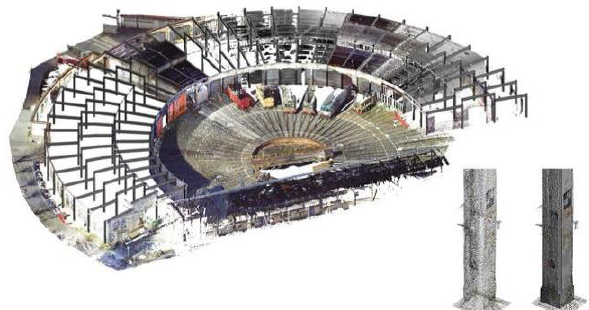
Figure 9. Overlapping between the structural system of beams and pillars and the total point cloud